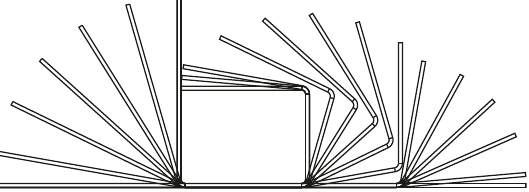
Figure 8: The b-shaped tube flower